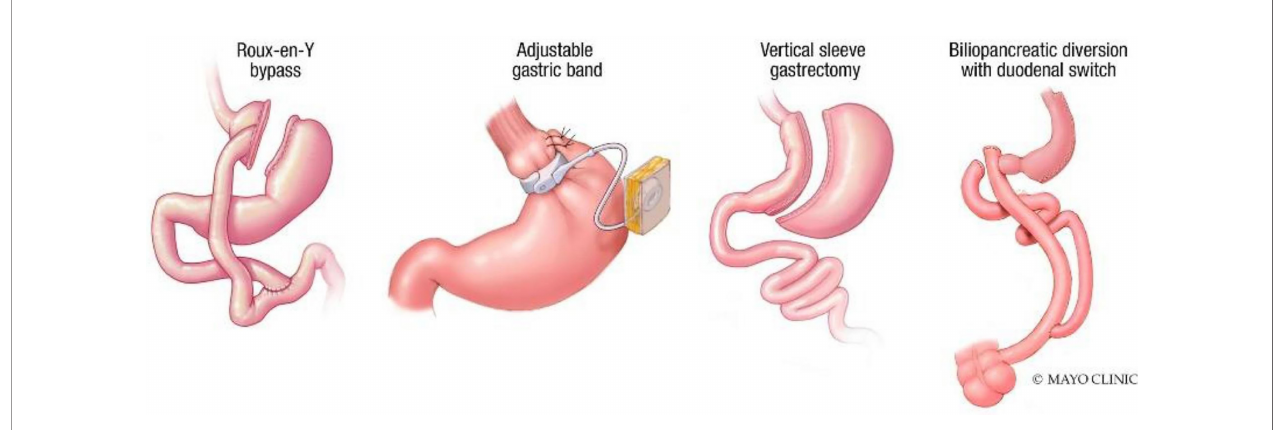
FIGURE 1 | The different bariatric